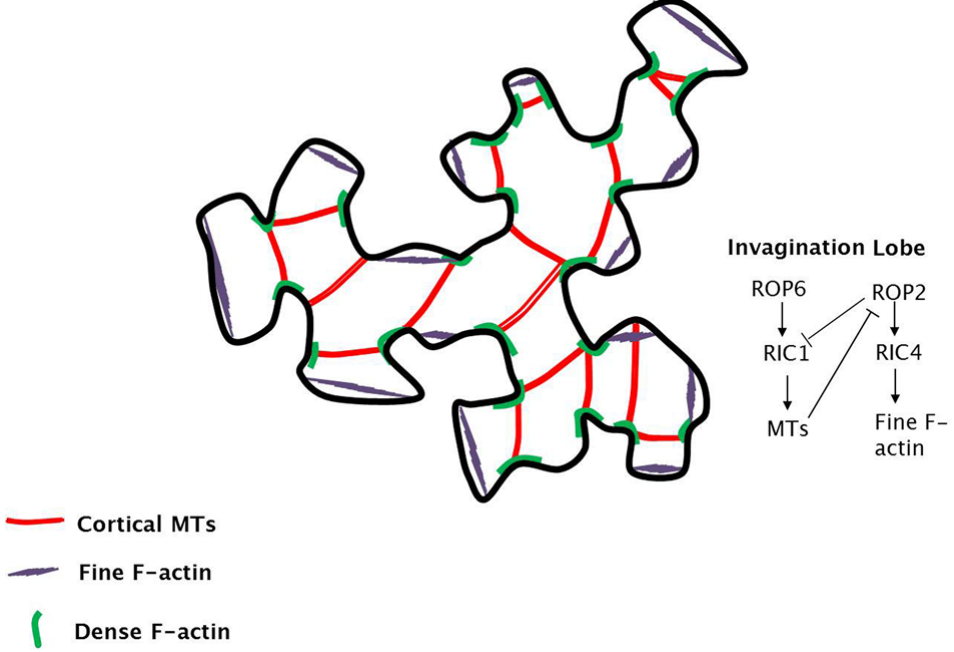
Figure 5. Schematic representation of the cytoskeletal architecture in a jigsaw puzzle-like pavement cell (as described in [36,53]). On the right, schematic molecular details on the relationship between Rho proteins and cytoskeleton are reported for the molecular control of interdigitated domains